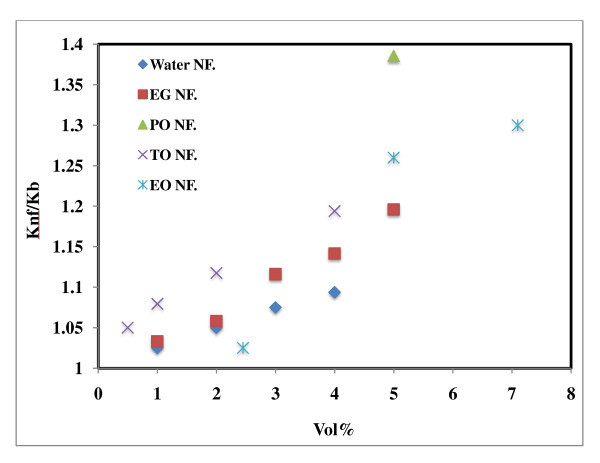
Effect of base fluids on thermal conductivity of Al2O3-based nanofluids. Water NF [7], EG NF [18], PO NF [16], TO NF [12], EO NF [8].